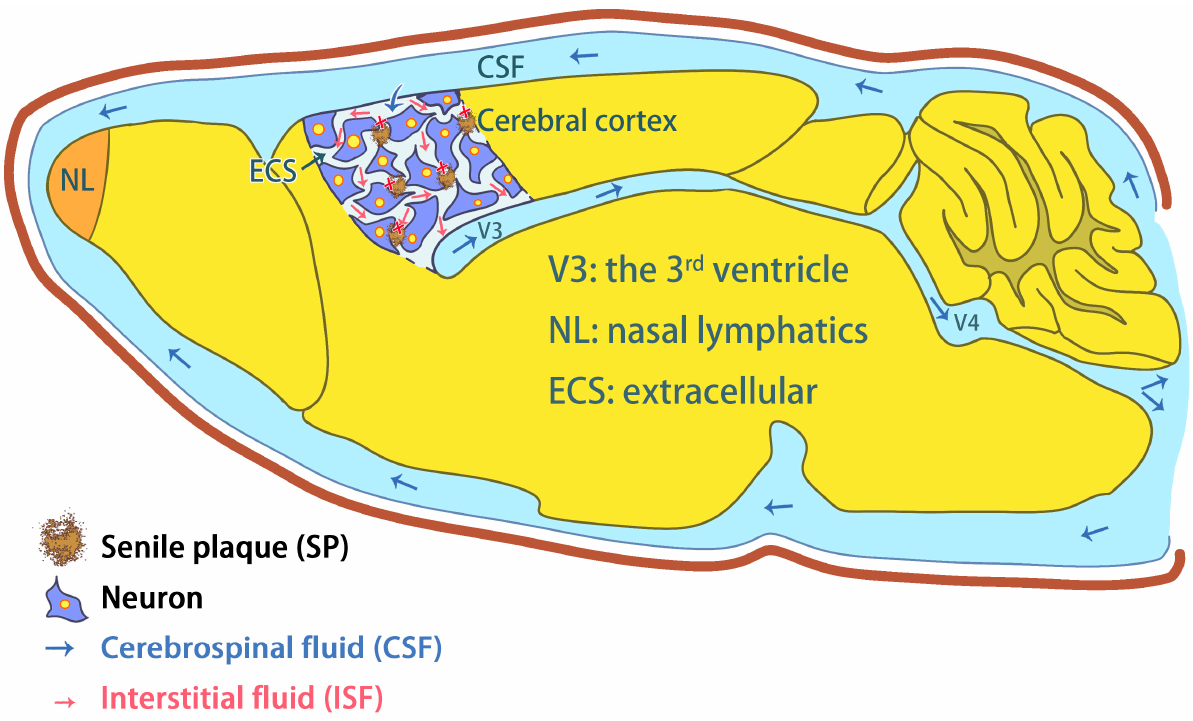
Figure 2. Interstitial fluid (ISF) drainage flows from the superficial cortex and then deep into the brain to the 3rd ventricle pouring into the cerebrospinal fluid (CSF). Finally, CSF flows into nasal lymphatics (NL) where the substances are exchanged with blood [18]. Formaldehyde-induced A β deposition in the ECS blocks the exchange between ISF and CSF.